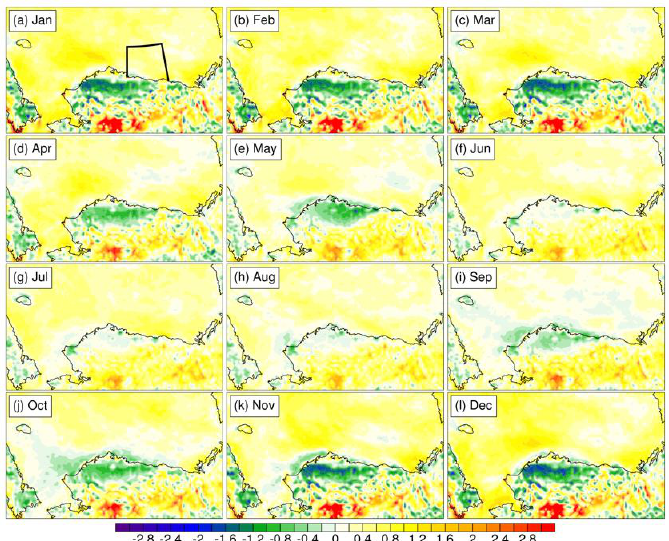
Figure 2. Monthly difference downscaled ERA-Interim minus CBHAR of daily 90th percentile wind speed threshold for 1979 – 2009. The month is displayed in each panel and units are m/s. The region of the sea ice analysis is outlined by the box in ( a ).